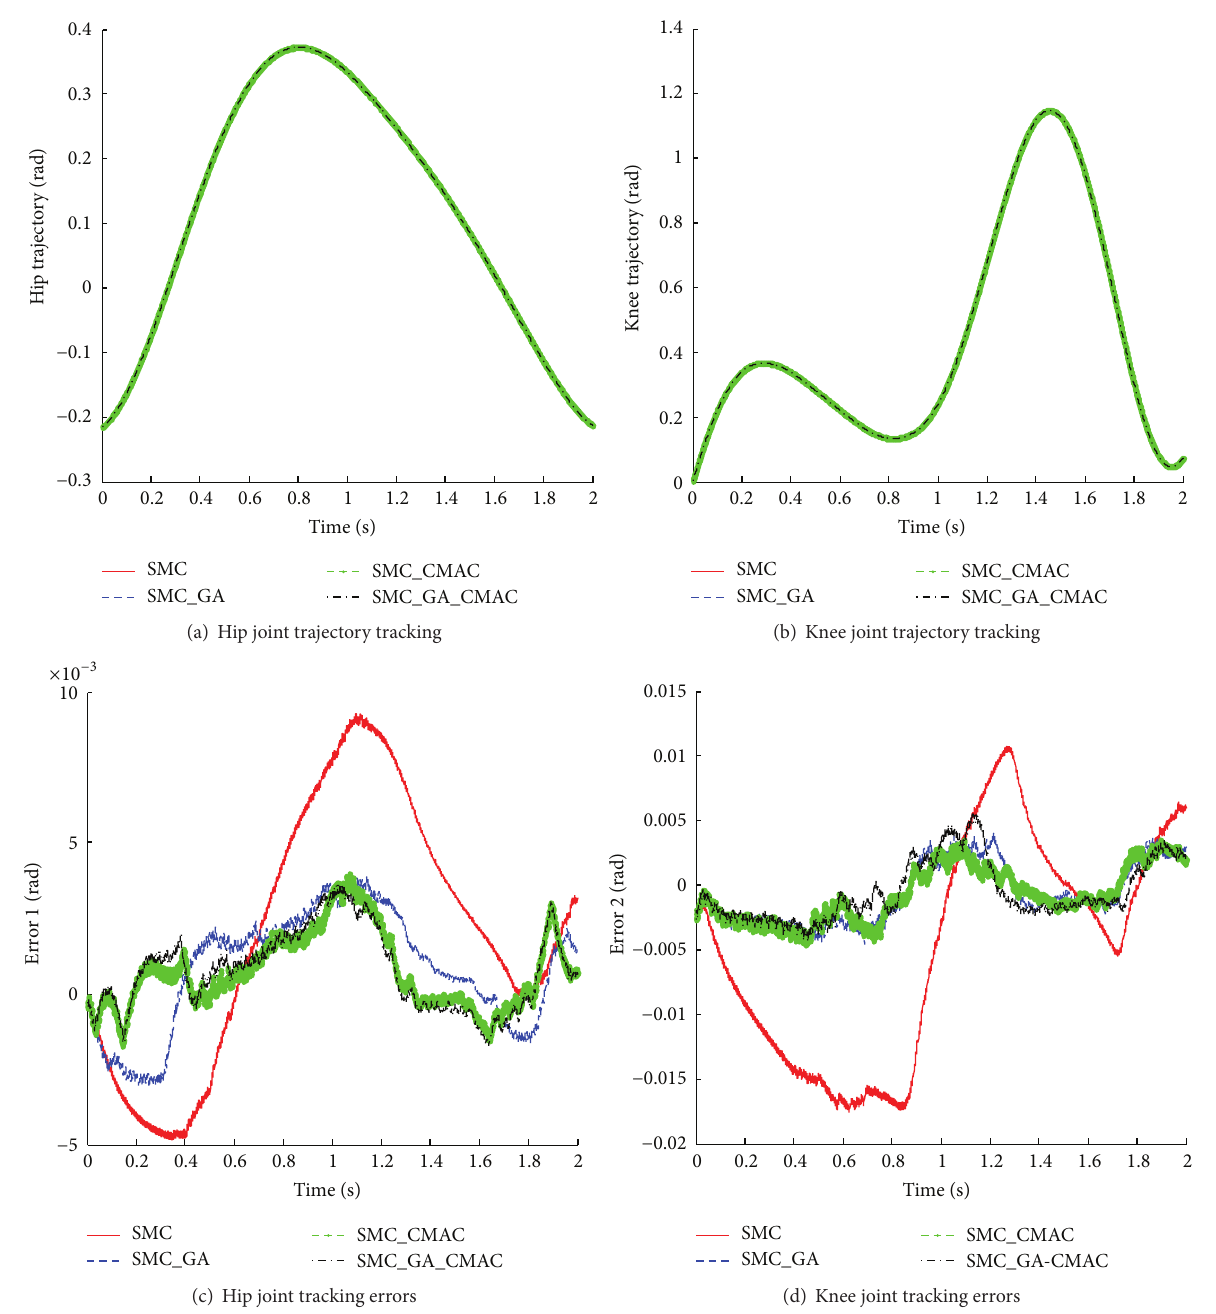
Figure 9: The performance comparisons using four methods in Case